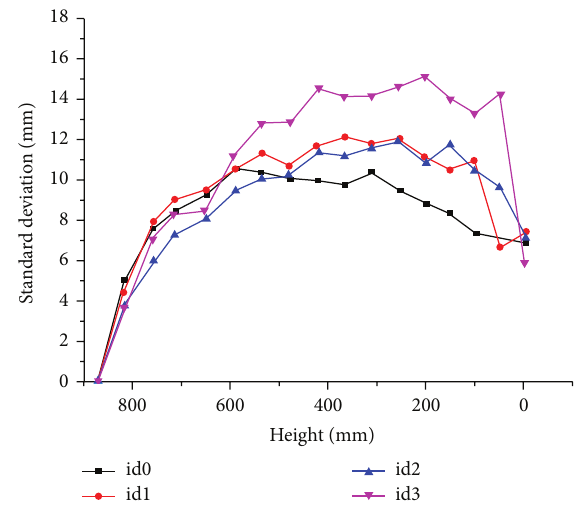
Figure 7: The variation trend of standard deviations of tracks.